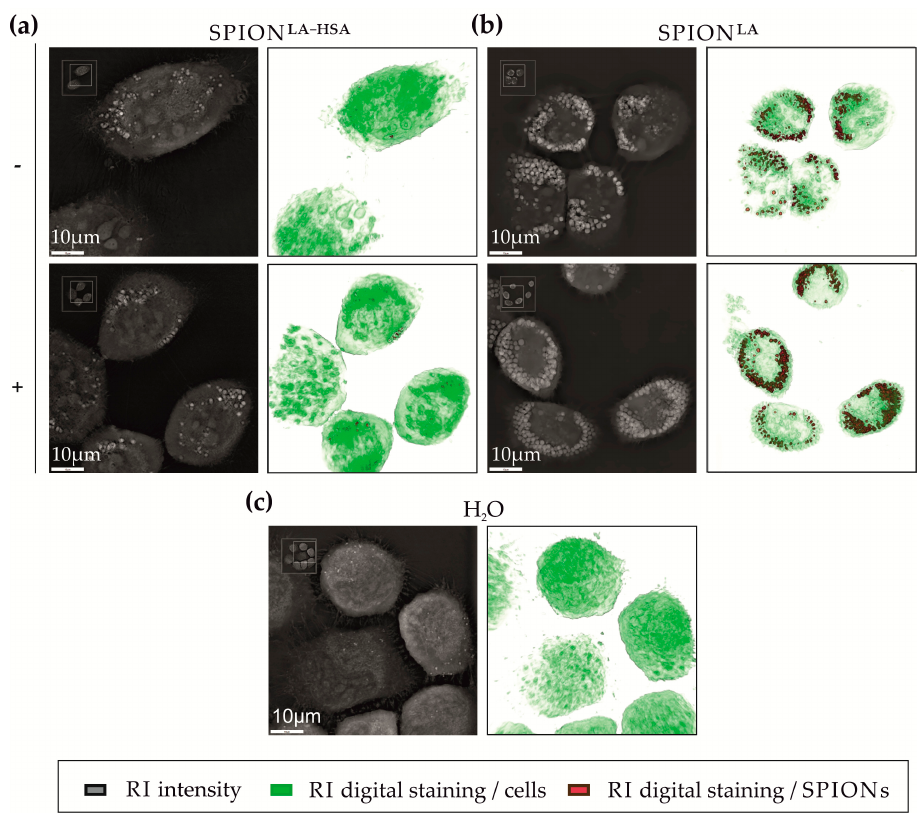
Figure 2. Holotomographic imaging of SCC-9 cells after incubation with SPIONs. Cells were incubated with SPIONs in the presence and absence of an external magnet. Cells were treated with unlabeled ( a ) SPION LA-HSA and ( b ) SPION LA (100 µgFe/mL) in the presence (+) or absence ( − ) of a magnet or with the corresponding amount of ( c ) H 2 O for 48 h and visualized by differences in refractive index. The 2D black and white images depict X-Y sections of the 3D RI composition. The 3D RI hologram is digitally colored, showing structures with low RI (cell nuclei, nucleoli and cytoplasm) in green and high RI (SPION clusters) in reddish-brown. The colored images show the top view of the 3D holograms. Abbreviations: SPION, superparamagnetic iron oxide nanoparticles; SPION LA , lauric acid-coated SPIONs; SPION LA-HSA , lauric acid- and human serum albumin-coated SPIONs; RI, refractive index.